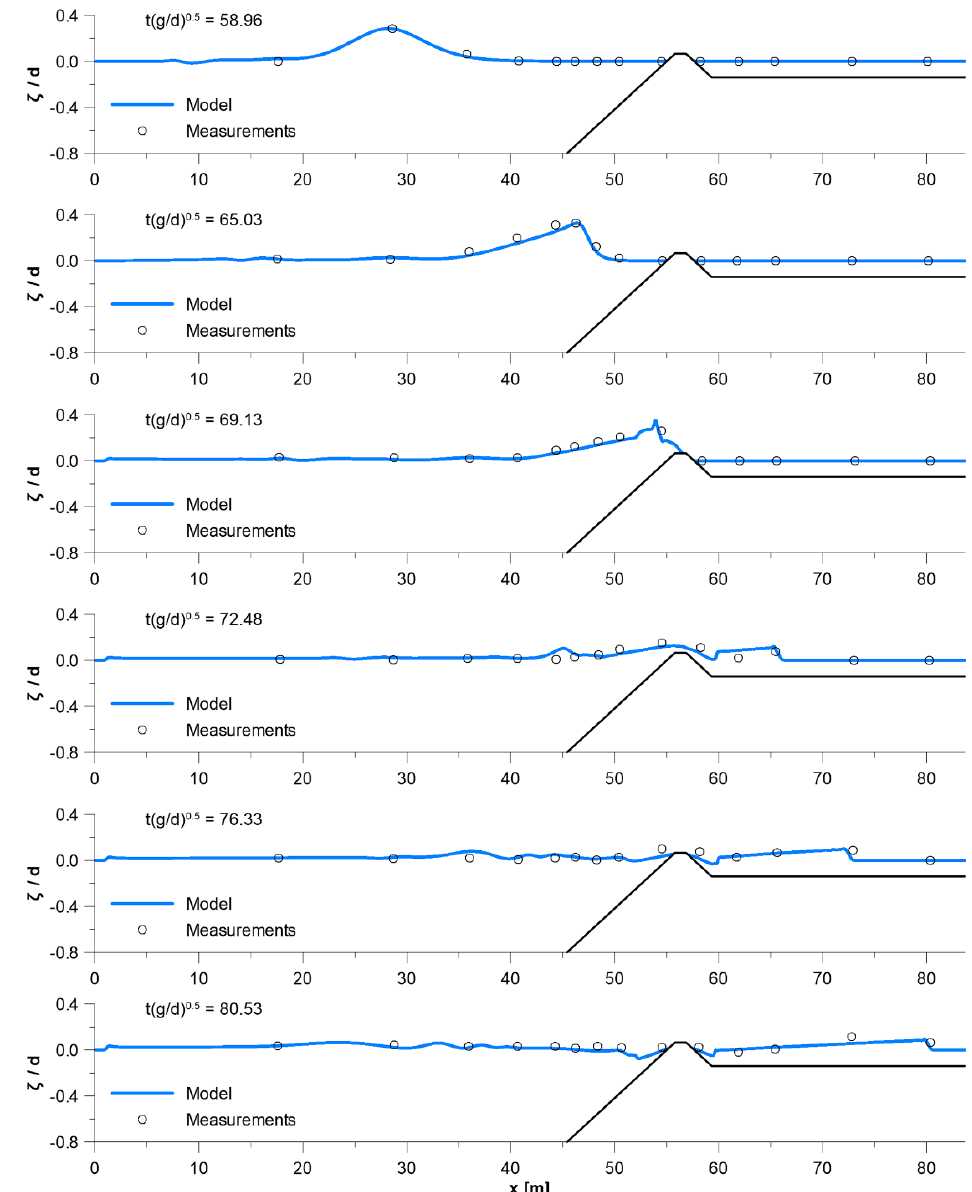
Figure 2. Surface profiles of solitary wave transformation over an exposed reef crest with A/d = 0.3 and a 1:12 slope. Solid lines denote the results of the presented advanced nearshore wave propagation model (see Section 2.3) and circles denote the measurements of [38].